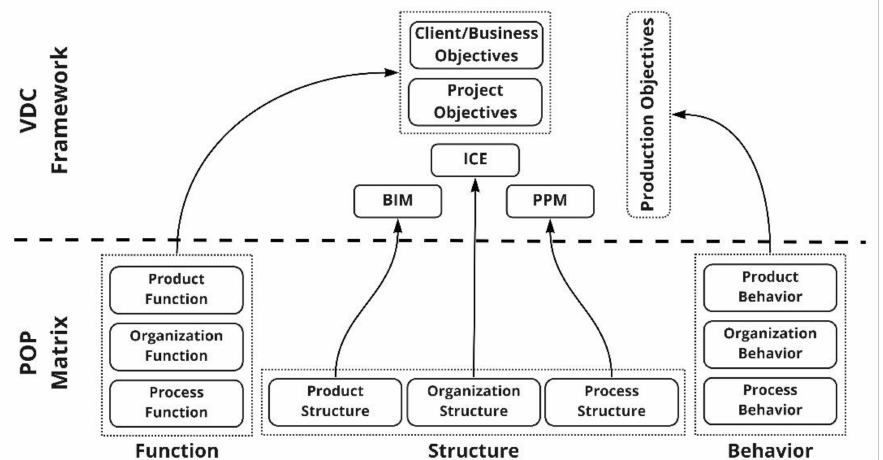
Figure 2. The relationship between the POP Matrix (bottom of the figure) and the VDC Framework (top of the figure) is built from Table 1 and Figure